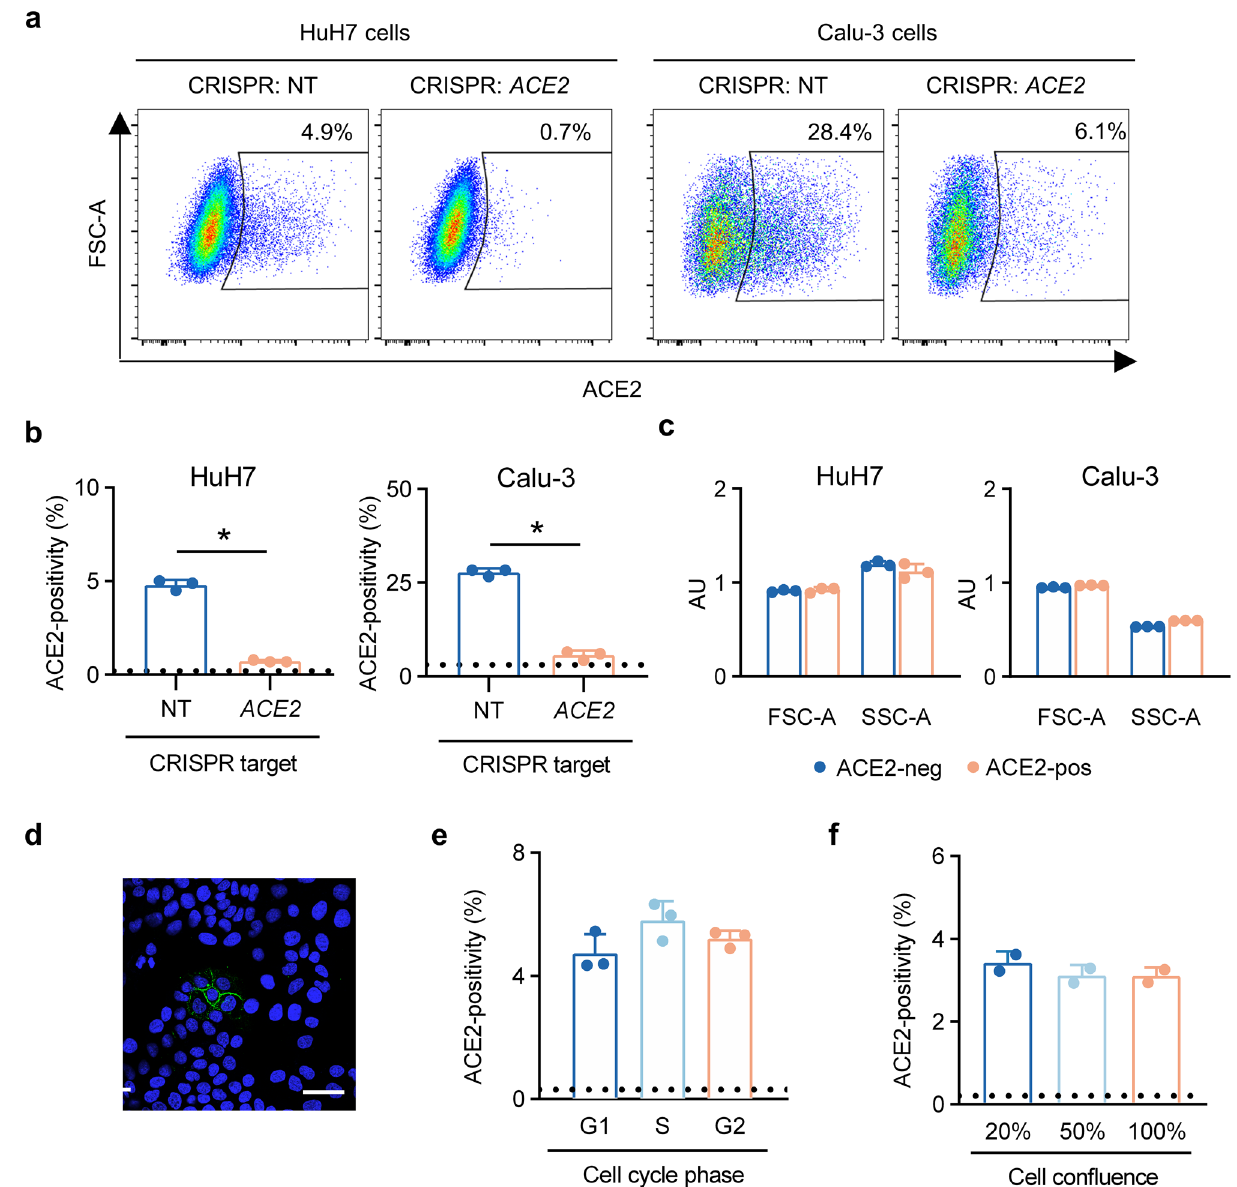
Figure 2. Heterogeneous ACE2 surface abundance in HuH7 and Calu-3 cells. ( a ) Surface staining of endogenous ACE2 by flow cytometry in HuH7 and Calu-3 cells targeted by CRISPR with either a nontargeting or ACE2 -targeting gRNA. ( b ) Proportion of ACE2-positive cells as determined by flow cytometry in HuH7 and Calu-3 cells targeted by CRISPR with either a nontargeting or ACE2 -targeting gRNA. Dashed lines represent background signal in wild-type cells stained with secondary antibody only. ( c ) Comparison of mean forward and side scatter parameters as determined by flow cytometry in gated ACE2-negative and ACE2-positive HuH7 cell populations. ( d ) Confocal immunofluorescence microscopy of HuH7 cells with endogenous ACE2 (green) and Hoechst nuclear staining (blue). Scale bar = 50 µm. ( e ) ACE2-positivity by flow cytometry within each phase of the cell cycle, as determined by propidium iodide staining. ( f ) ACE2-positivity as determined by flow cytometry in wild-type HuH7 cells harvested at a range of cell densities. Asterisk indicates p < 0.05 by two-tailed Student’s t test. Error bars represent standard deviation. All ACE2 immunofluorescence and flow cytometry experiments in this figure were performed with R&D